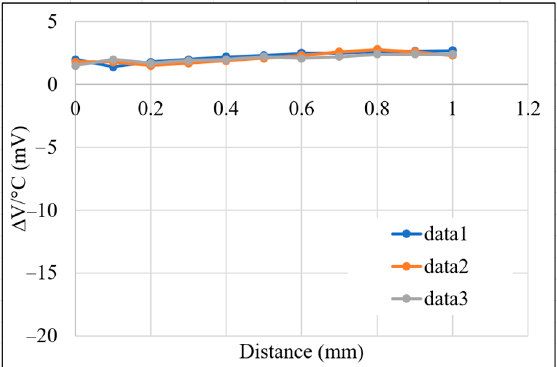
Figure 14. Correlation between temperature drift and sensing distance following temperature compensation.